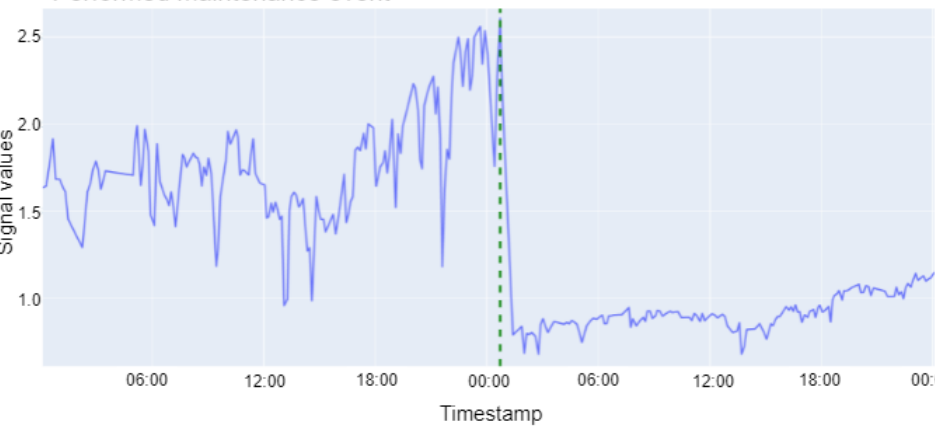
Figure 2. An example of performed maintenance event. The maintenance intervention is indicated by the dashed vertical line in green. The sensor yields higher absolute values and higher variability before the maintenance compared to the sensor values after the maintenance event is